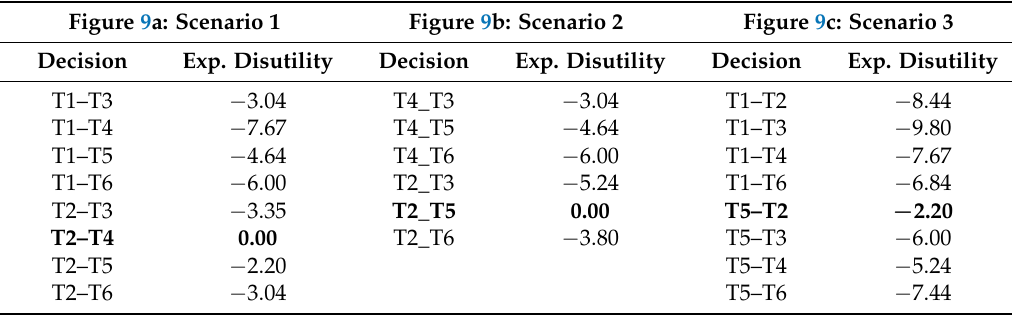
Table 6. Expected (Exp) disutility of firefighting strategies for fire scenarios. Figure 9a: Scenario 1 Figure 9b: Scenario 2 Figure 9c: Scenario